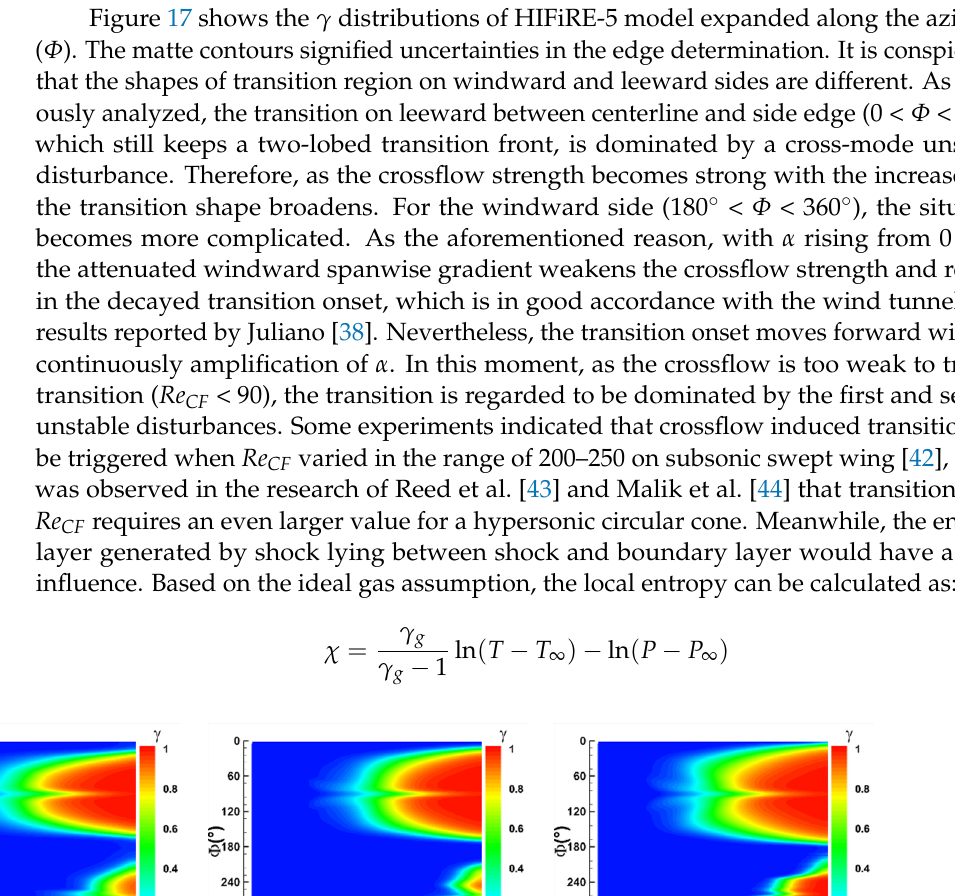
Figure 16. Characteristics of flow field of HIFiRE-5 under different α . ( a ) α = 2°, ( b ) α = 4°, ( c ) α = 6°.